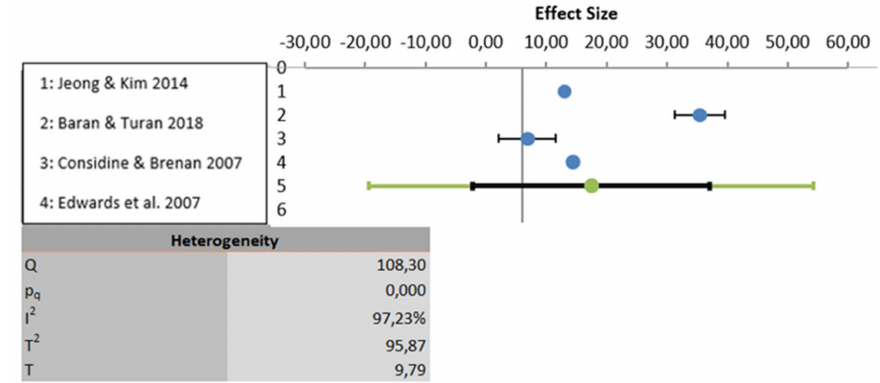
Figure 2. Data analyzed for the variable